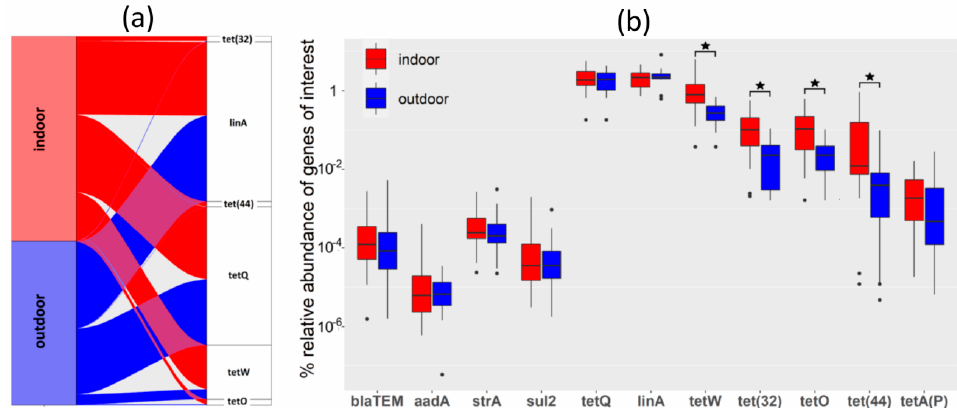
Figure 4. Abundance of antibiotic resistance genes in microbiota of commercial and backyard hens. ( a ) Abundance of the most common antibiotic resistance genes in total microbiota and their association with indoor or outdoor chickens. ( b ) Abundance of all analyzed antibiotic resistance genes in total microbiota in hens from indoor, commercial poultry flocks (red color) and outdoor, backyard poultry flocks (blue color). * significantly different by Mann–Whitney test, p < 0.05.